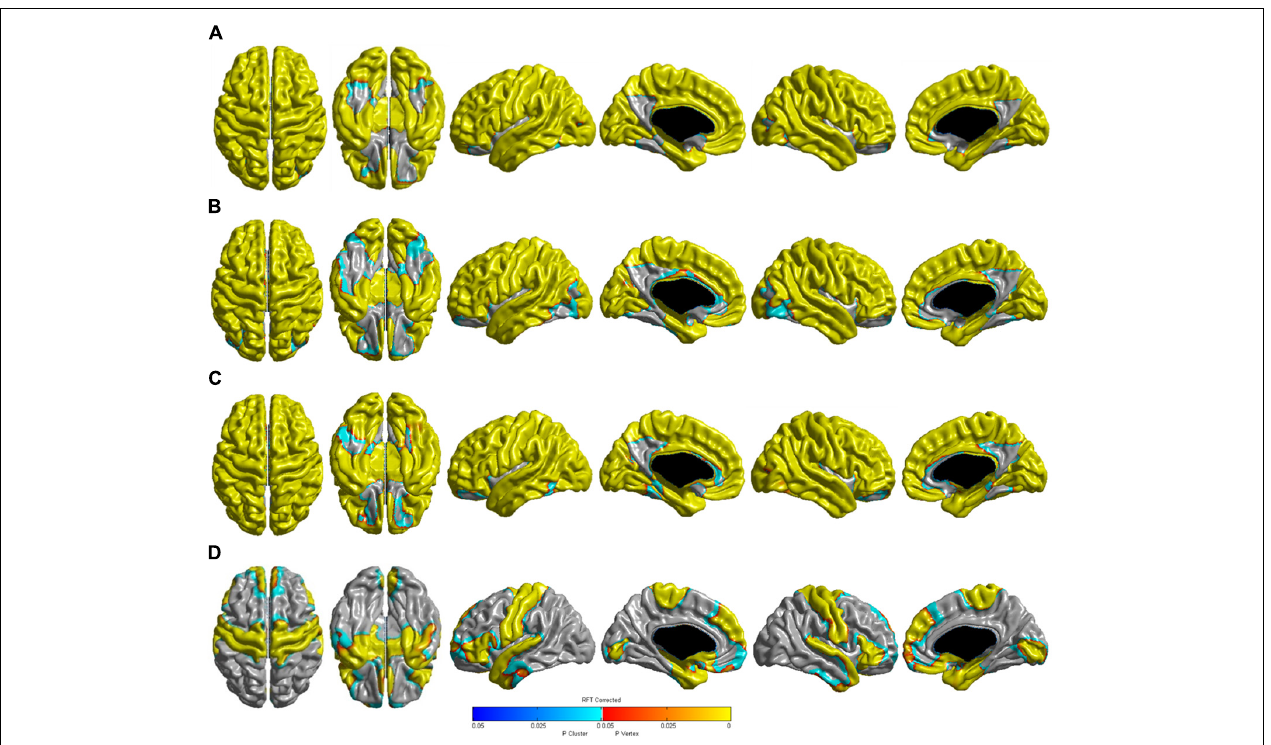
FIGURE 1 | Three-dimensional reconstruction of the correlation between age (continuous) and cortical thickness in the (A) CN, (B) SMI, (C) aMCI, and (D) AD groups. RFT-corrected ( P -value < 0.05) results were adjusted for sex, education years, ICV, vascular risk factors (hypertension, diabetes mellitus, and hyperlipidemia), and history of ischemic heart disease or stroke. The color scale from blue to yellow indicates statistically significant age-related cortical thinning. CN, cognitively normal; SMI, subjective memory impairment; aMCI, amnestic mild cognitive impairment; AD, Alzheimer’s disease; RFT, random field theory; ICV, intracranial